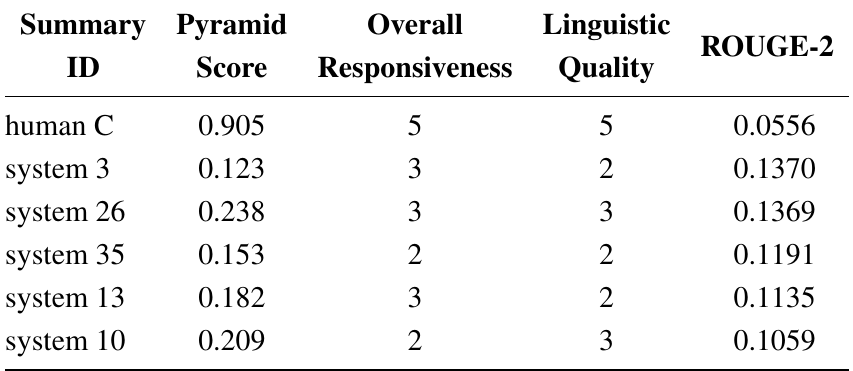
Table 1. Contrast between human and system scores for data set